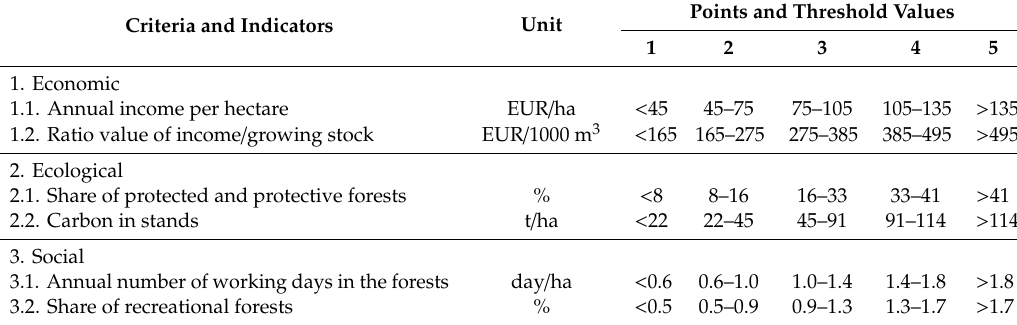
Table 1. The threshold values for the assessment of Lithuanian private forestry